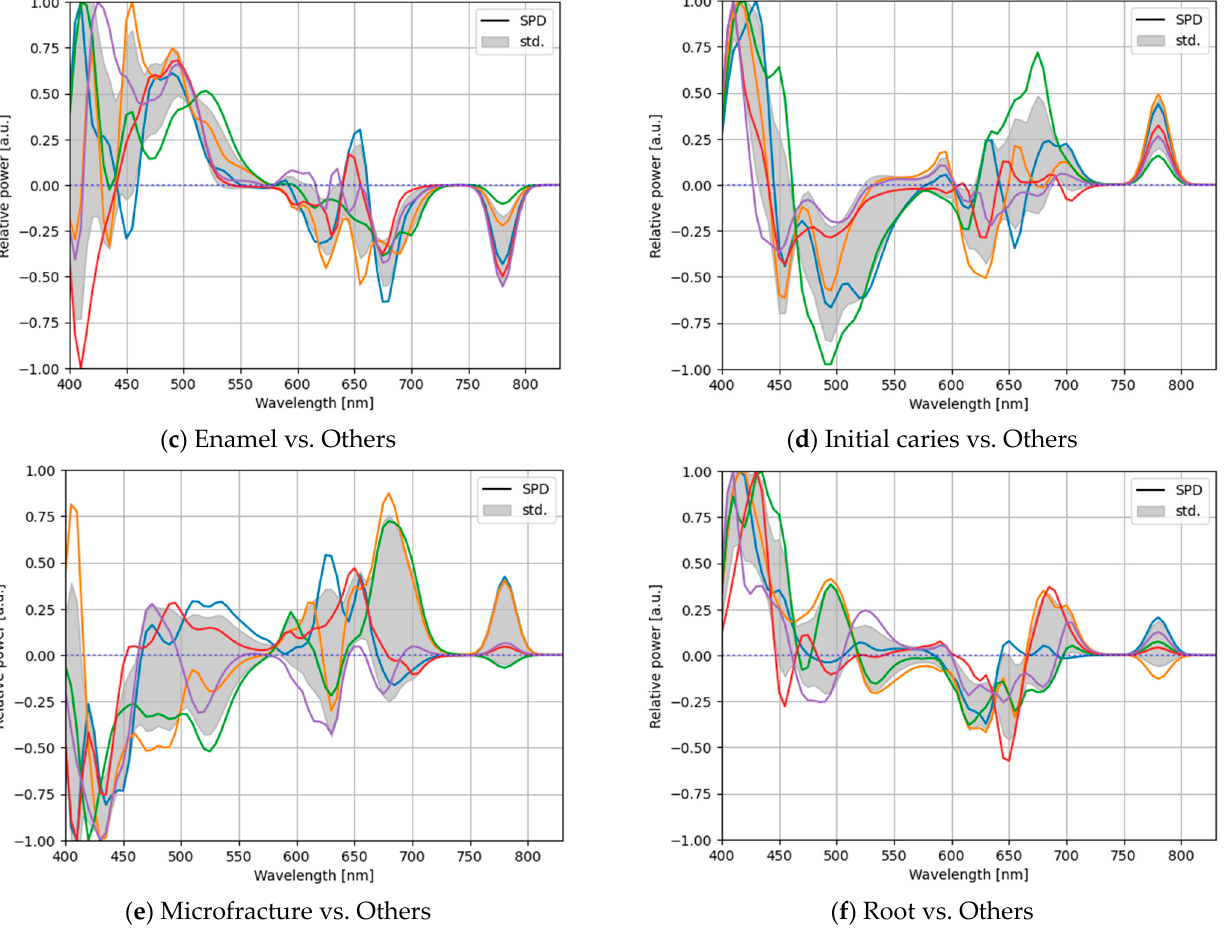
Figure 13. The optimal SPDs of the CNN-based optimization in a five-fold cross-validation with the measured LEDs having spectral powers in the 400–830 nm band for each classification of one-vs-rest classification: ( a ) attrition and erosion vs. others, ( b ) calculus vs. others, ( c ) enamel vs. others, ( d ) initial caries vs. others, ( e ) microfracture vs. others, and ( f ) root vs. others.